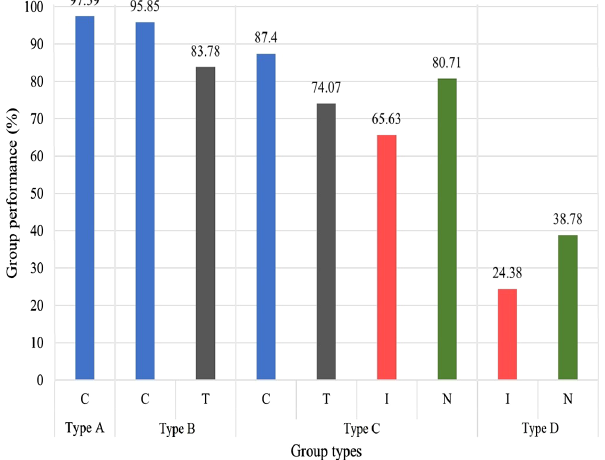
FIG. 2. Group performance according to a majority of correct or incorrect answers of group members ’ individual-round answers.